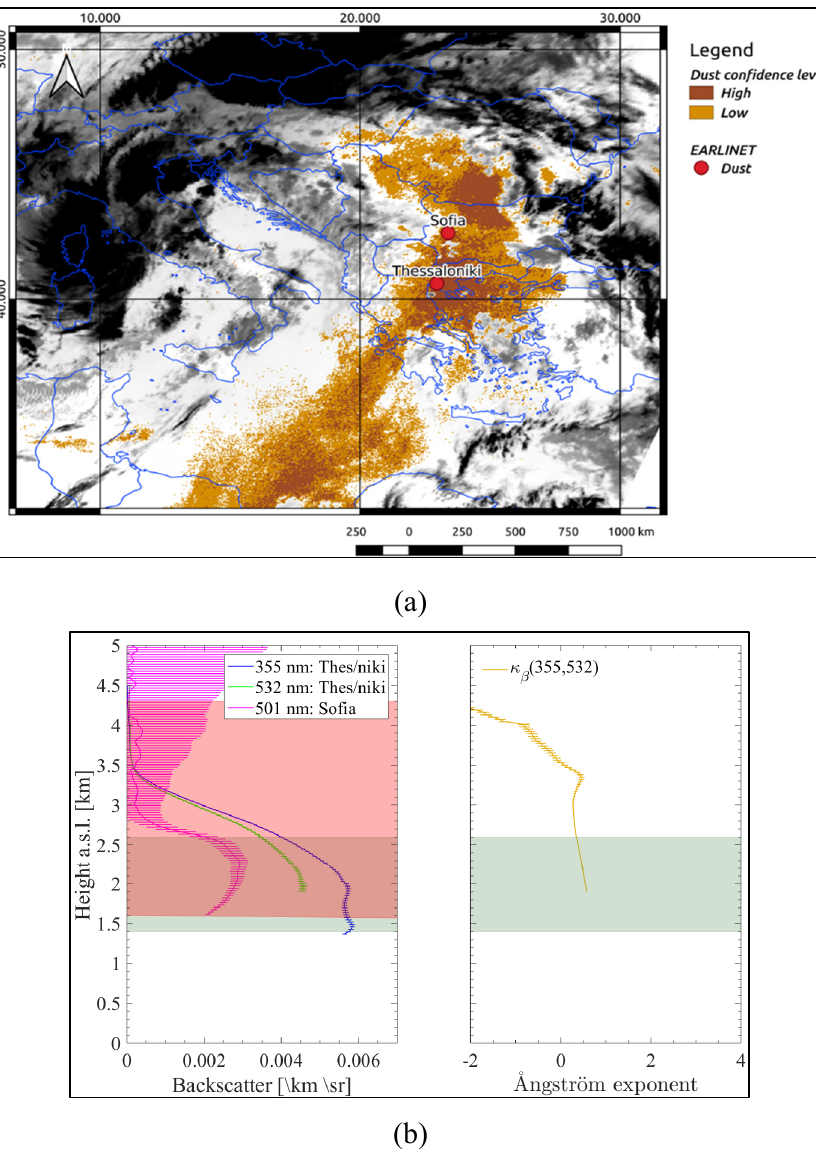
Figure 2. ( a ) e RST DUST map from SEVIRI data on May 20 at 08:45 UTC. ( b ) Sophia and Thessaloniki EARLINET aerosol backscatter coe ffi cient, and Angstrom exponent profiles acquired the same day between 08:48–09:20 UTC showing a dust layer in the 1.8–4.7 km a.s.l. and 1.4–4.8 km a.s.l. altitude range, respectively (see Figure 3d).